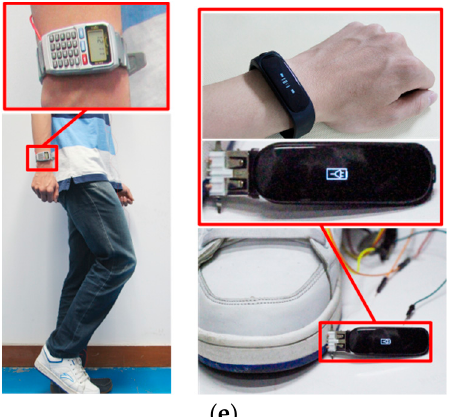
Figure 2. Typical electrical performance and application of the self-powered insole. ( a ) Open-circuit voltage output of the insole. ( b ) Short-circuit charge output of the insole. ( c ) Average power output from a load resistor. ( d ) DC ouput from the power management circuit. ( e ) Demonstration of a self-powered watch and a smart band being charged by the insole.